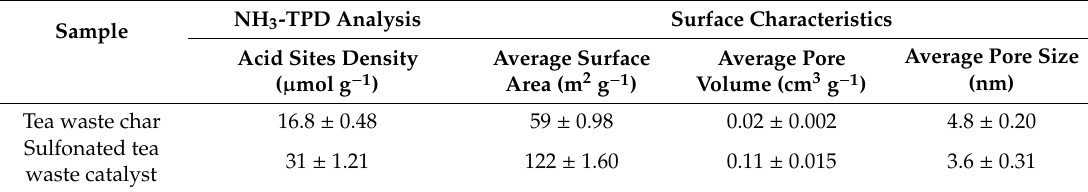
Table 1. Acid density and surface characterization of tea waste char and sulfonated tea waste